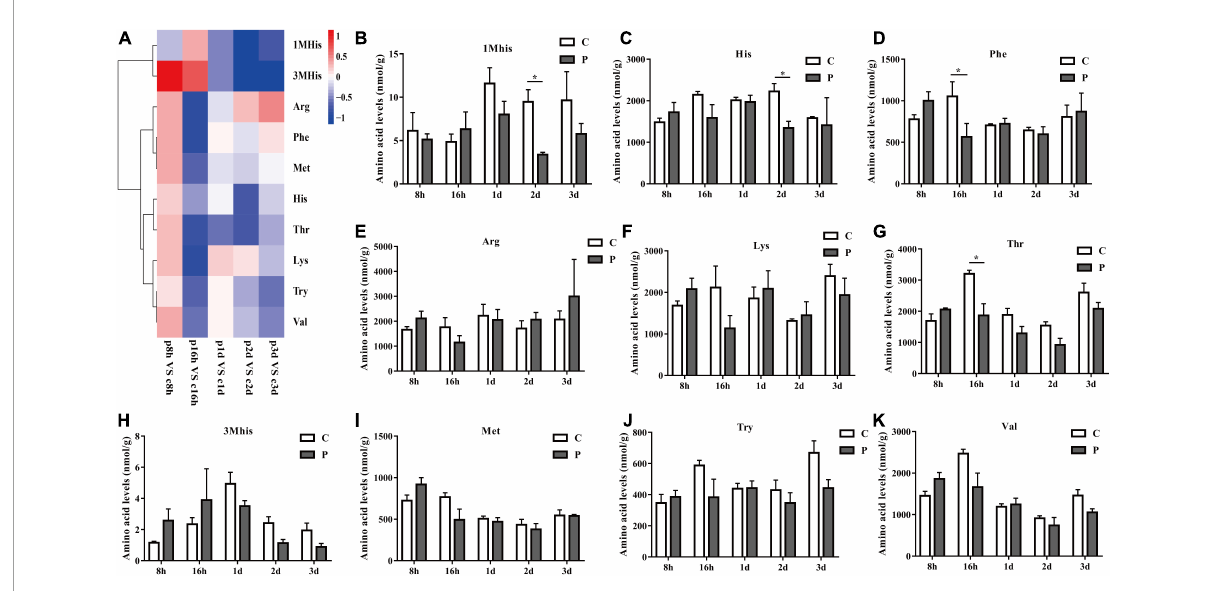
FIGURE3 Parasitism leads to the change of EAA content of cotton aphid. Heatmap (A) and column (B–K) display of changes in EAA. 1Mhis, 1-Methyl-L-histidine; 3Mhis, 3-Methyl-L-histidine; C, Non-parasitized cotton aphids; P, Parasitized cotton aphids. The log2(Fold change) of amino acid content change is represented by heat map color scale, red indicates up-regulation and blue indicates down-regulation. Statistical significance (Student’s t -test): * P < 0.05; ** P < 0.01; *** P <